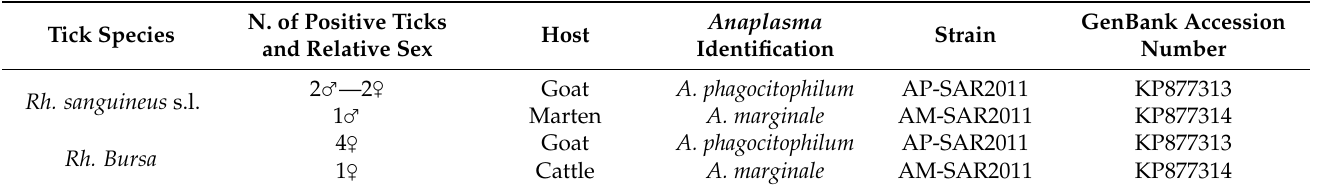
Table 2. Detection and identification by PCR and sequencing of A. phagocitophilum and A. marginale in ticks collected in Sardinia, Italy.